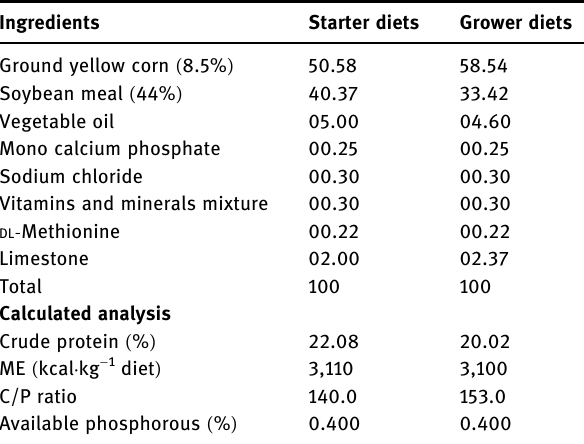
Table 1: Composition and calculated analysis of the experimental diet under this study